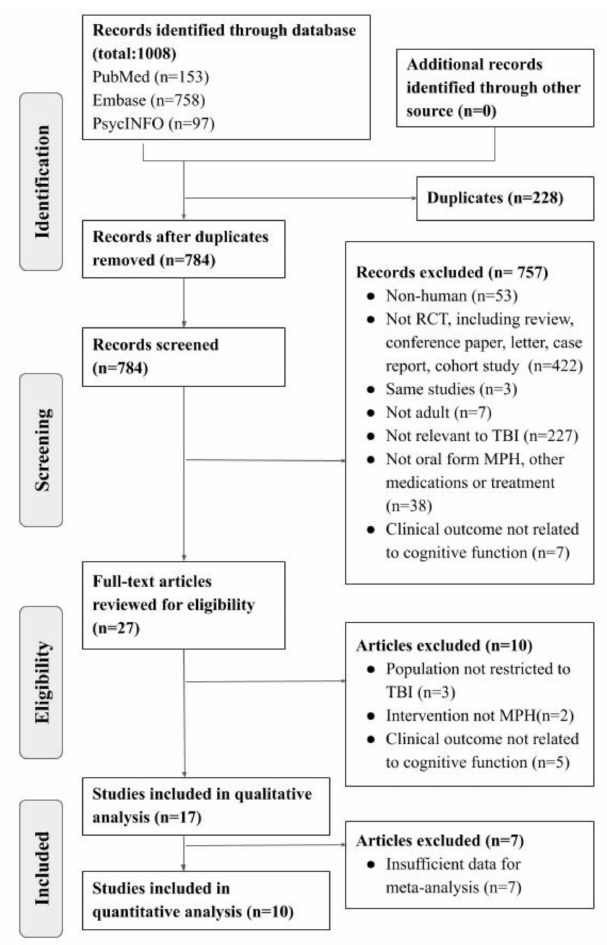
Figure 1. PRISMA (Preferred Reporting Items for Systematic Review and Meta-analysis) flow diagram. TBI: traumatic brain injury; MPH: methylphenidate; RCT: randomized control